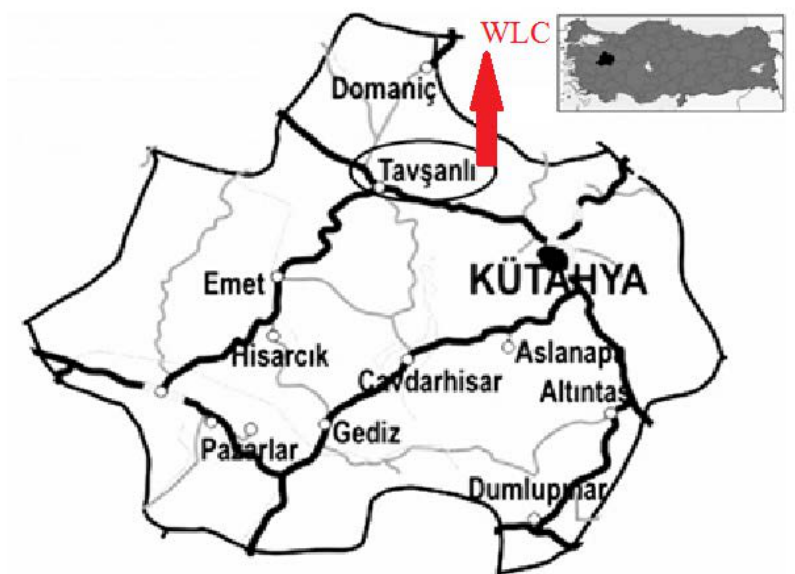
Figure 1. Map of Western Lignite Corporation Region